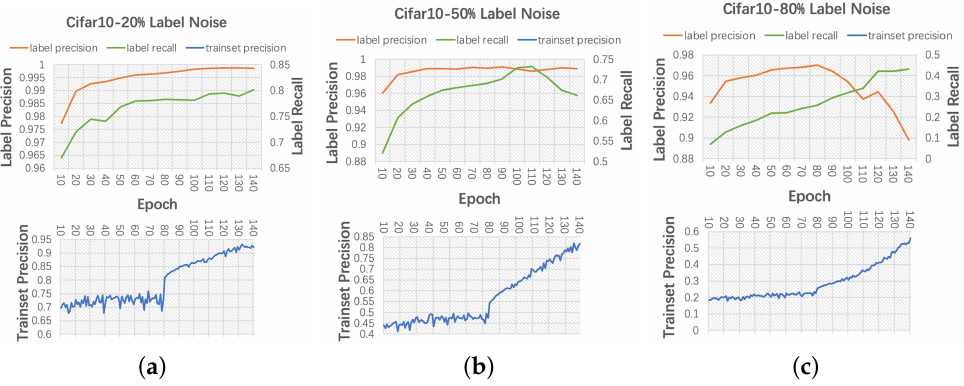
Figure 4. Precision and recall of labels produced by FGCM under different noise rates on CIFAR-10 dataset vs. the precision on trainset during training. The orange curves represent the precision of labels of the labeled trainset produced by FGCM. The green curves show the recall of the labeled trainset produced by FGCM. The blue curves illustrate the precision of models on the original trainset. ( a ) Results on CIFAR-10 with 20% symmetric label noise. ( b ) Results on CIFAR-10 with 50% symmetric label noise. ( c ) Results on CIFAR-10 with 80% symmetric label